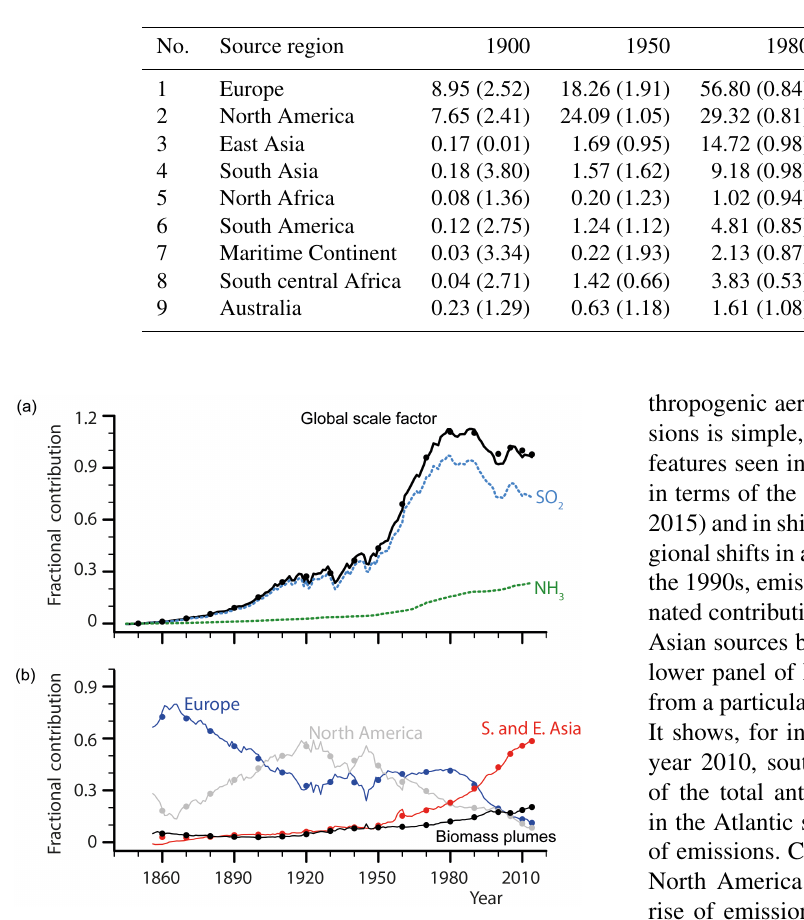
sorbing aerosol emissions, are tabulated for different time periods for the different plumes in Table